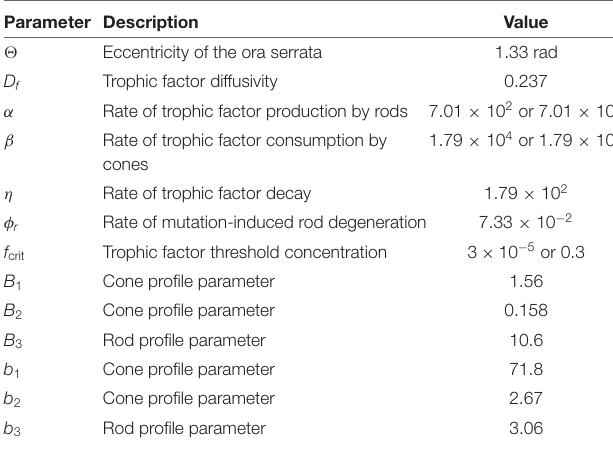
TABLE 2 | Parameters employed in the non-dimensional mathematical model [Equations (1–5)]. Values are given to three significant figures (radians are